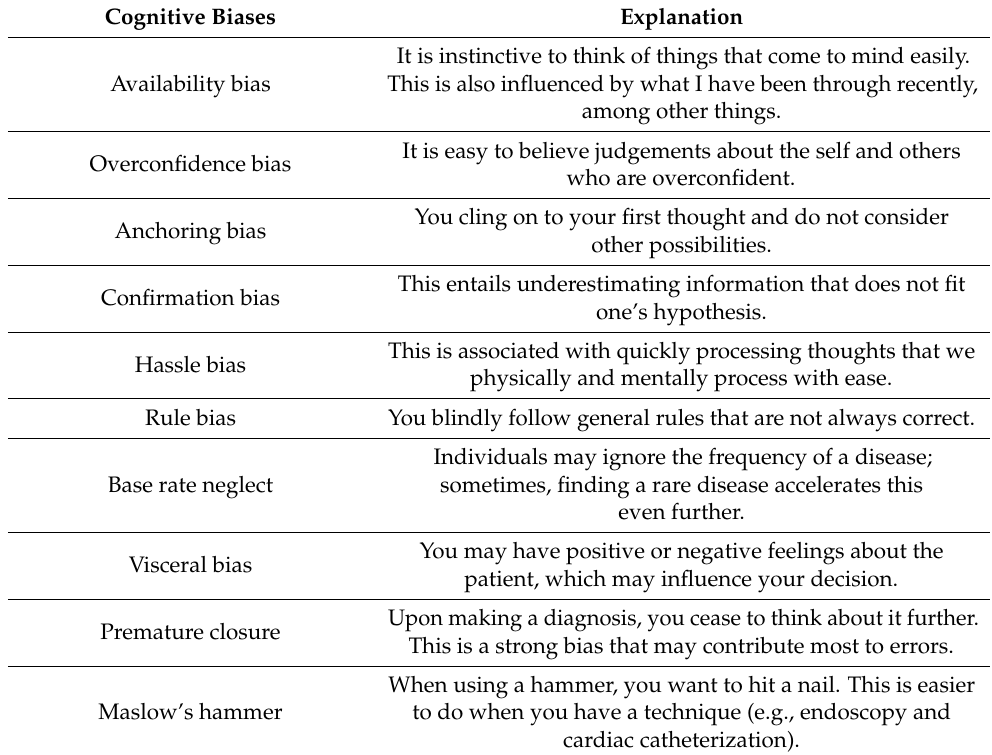
Table 1. List of representative cognitive biases shared with participants. Cognitive